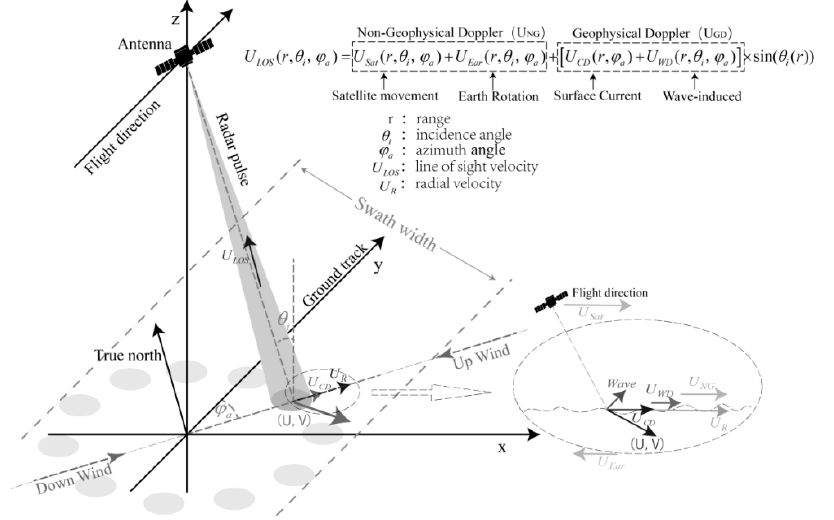
Figure 2. Schematic diagram of the measurement of sea surface currents using a rotating beam radar